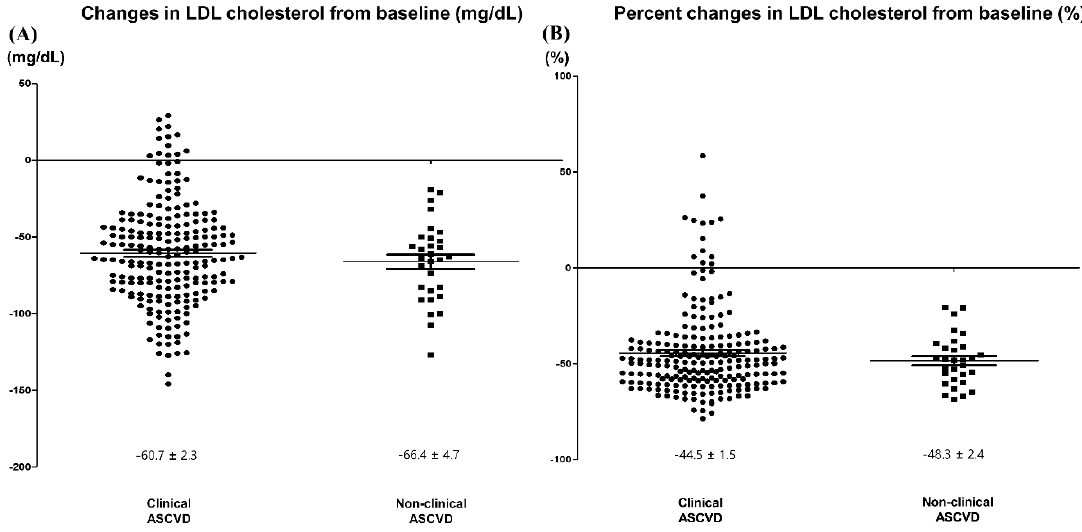
Figure 4. Changes in LDL cholesterol as per the ACC/AHA four statin benefit groups by clinical ASCVD. ( A ) Changes from baseline. ( B ) Percent changes from baseline. ASCVD: clinical atherosclerotic cardiovascular disease.